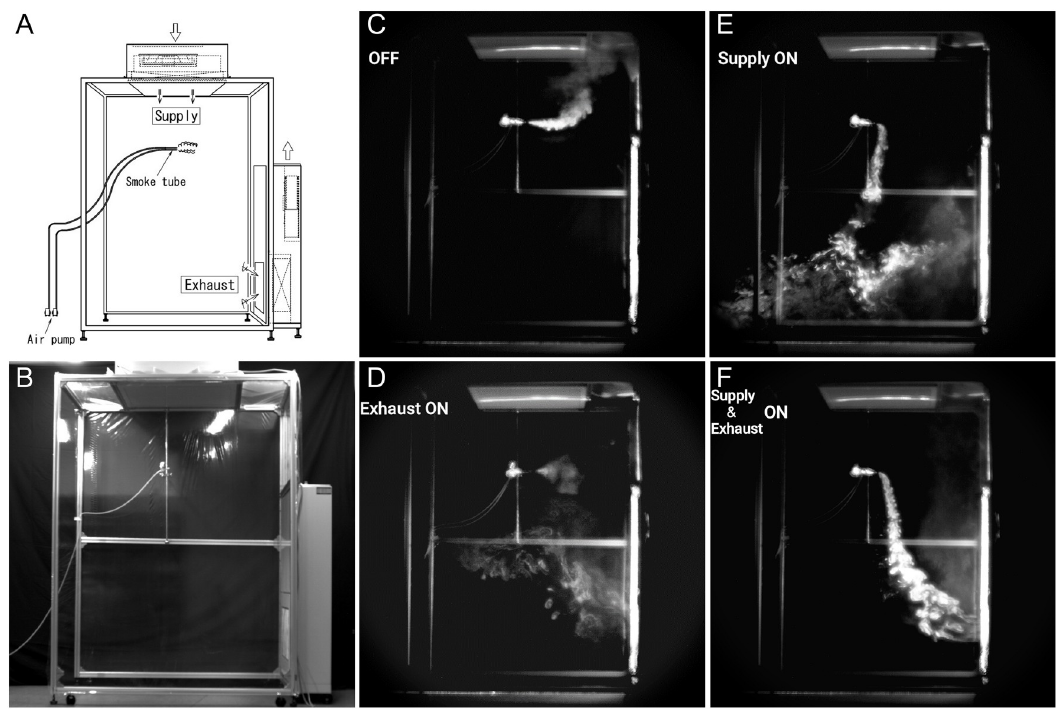
Fig 2. Performance of the laminar airflow ventilation system (LFVS) using artificial droplets. (A and B) The airflow was observed using an airflow indicator tube located at a position assumed to be the breathing. (C–F) The four types of vertical airflow, including (C) not-activating the LFVS, D: activating only the exhaust unit (Exhaust ON), (E) activating only the air supply unit (Supply ON), (F) activating the two units (Supply and Exhaust ON).